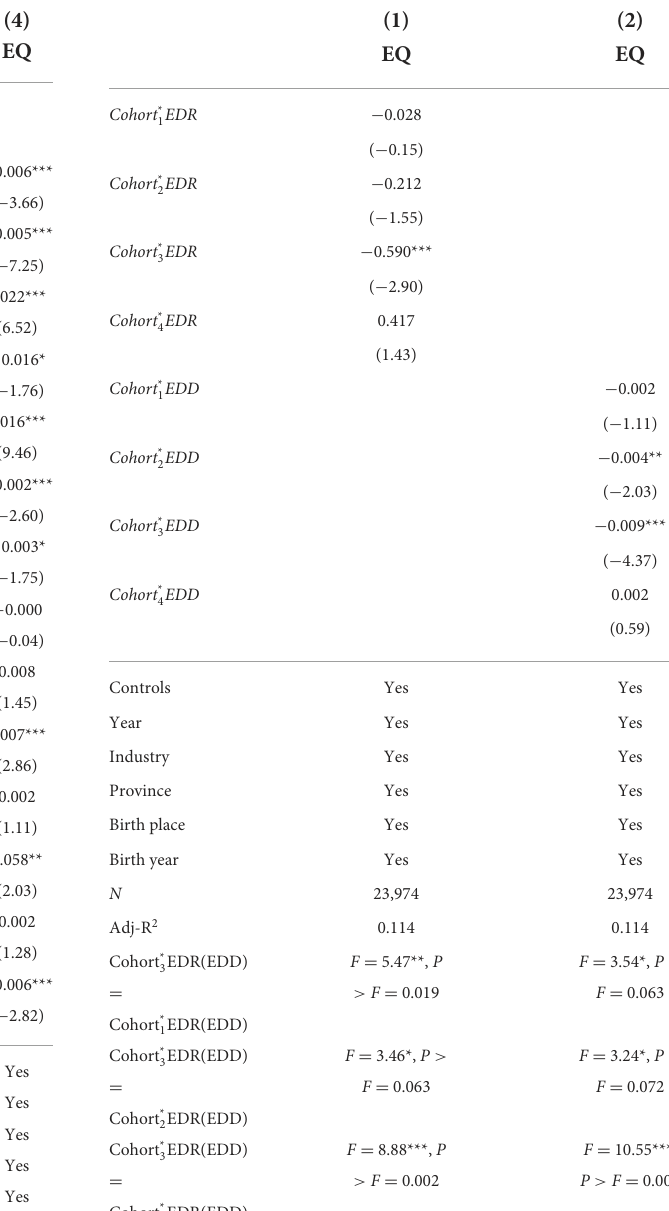
TABLE 5 Regression results for CEO age during the famine and the corporate earnings